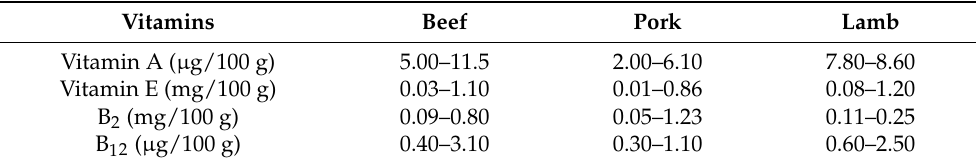
Table 1. Nutrient range of vitamins in red